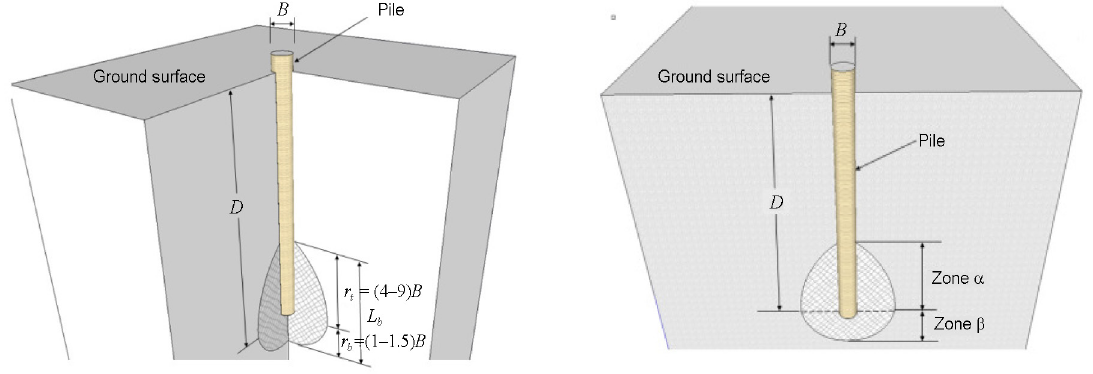
Fig. 2. Influence zone for averaging blows number near the pile